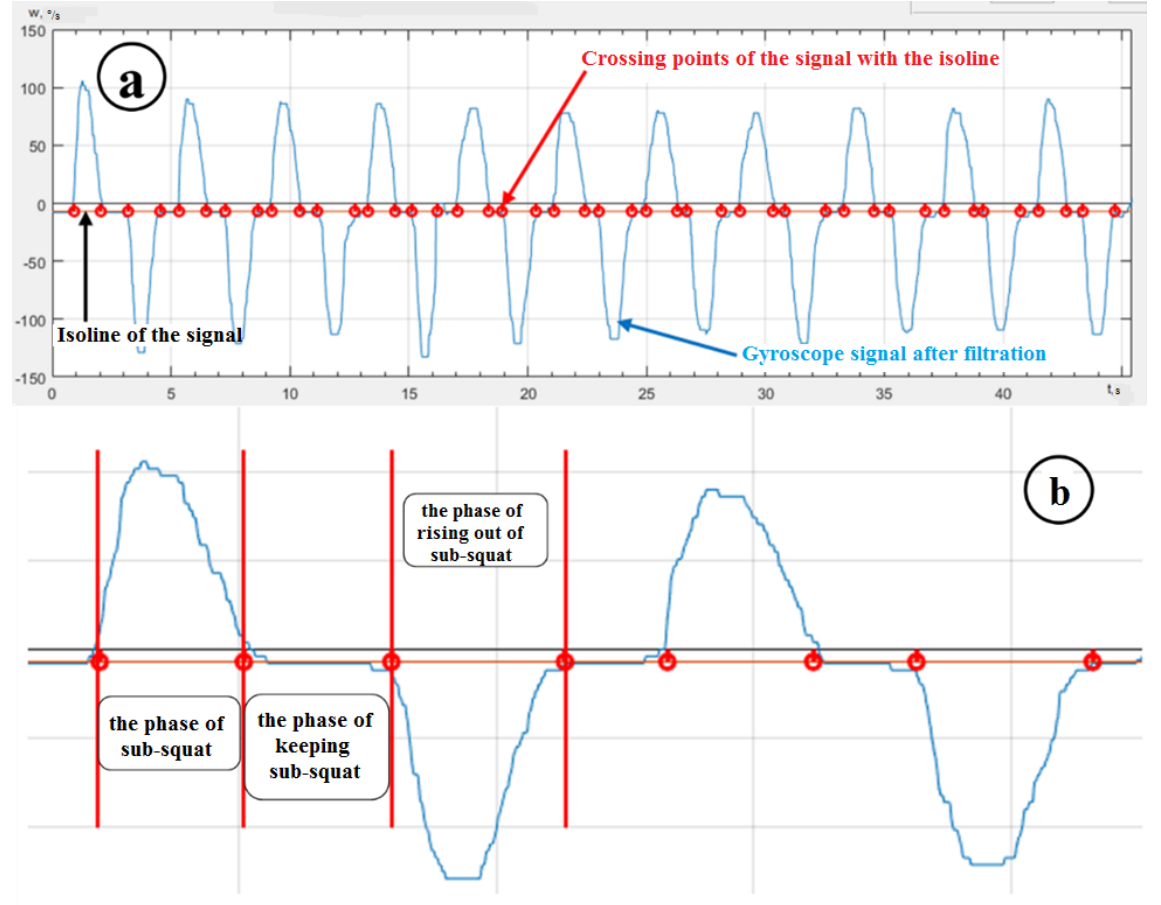
Figure 9 . Determining the squatting phases: а - the points of gyroscope signal crossing with the isoline (the gyroscope signal of the sensor fixed to the muscle "Rectus Femoris" of the left leg); b - the determined motion